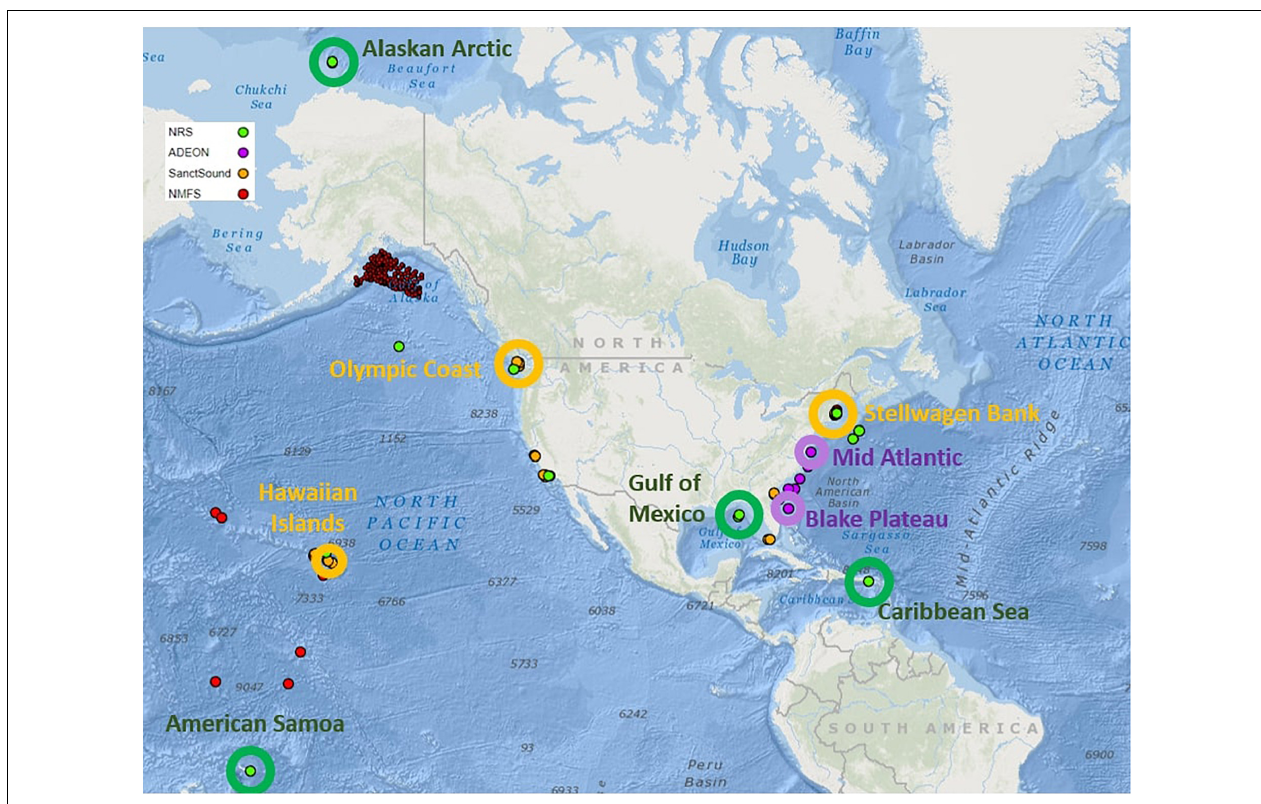
FIGURE 1 | Recording sites selected from the NCEI passive acoustic archive for analysis across the NRS (green open circles), ADEON (purple open circles), and SanctSound (orange open circles) projects. The red circles represent datasets collected by National Oceanic and Atmospheric Administration (NOAA) Fisheries Science Center monitoring